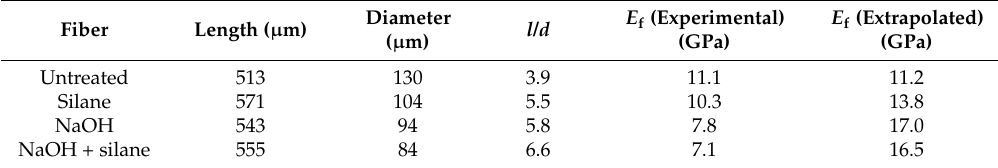
Table 4. Mean length, diameter, aspect ratio ( l / d ), extrapolated and experimental Young modulus values of untreated and treated sisal fibers used for predicting composites Young modulus.